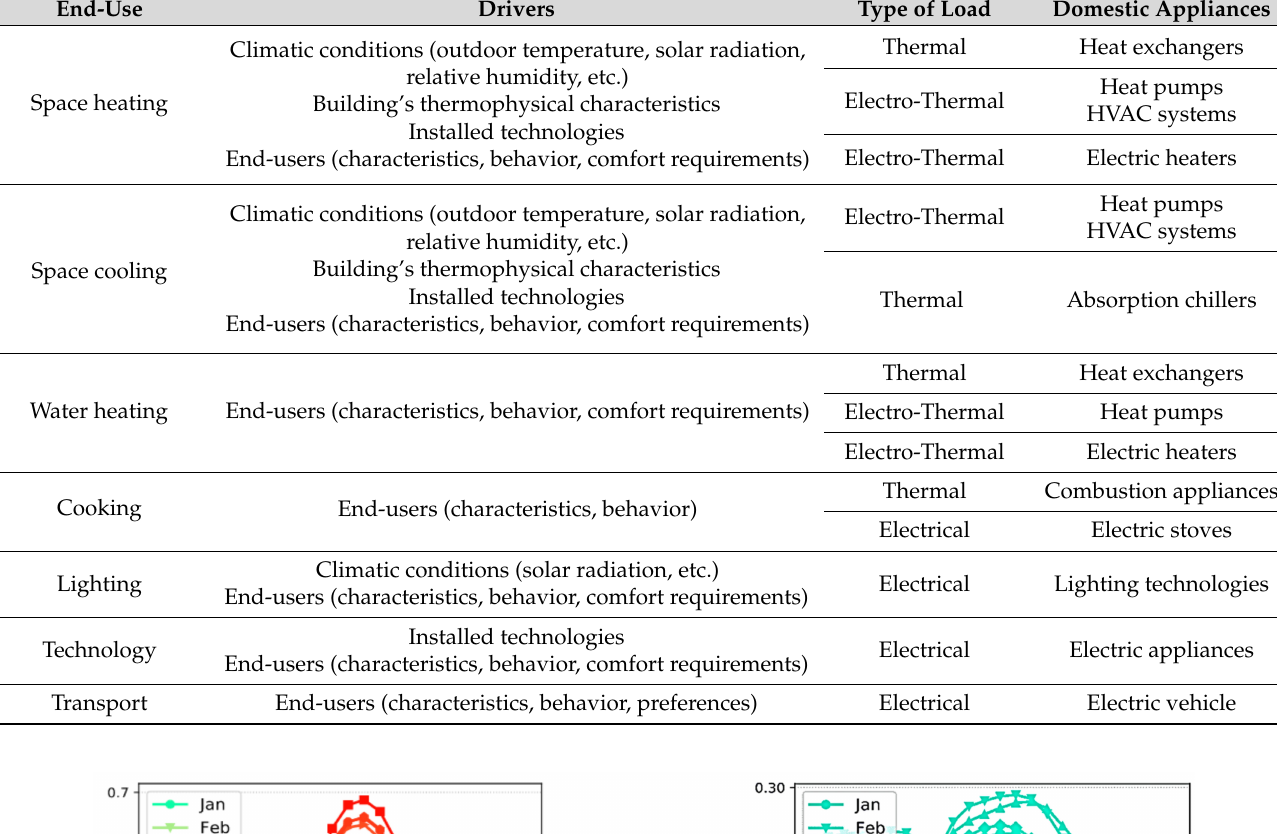
Table 3. Characterization of the residential energy demand in terms of end-uses, main drivers and appliances.